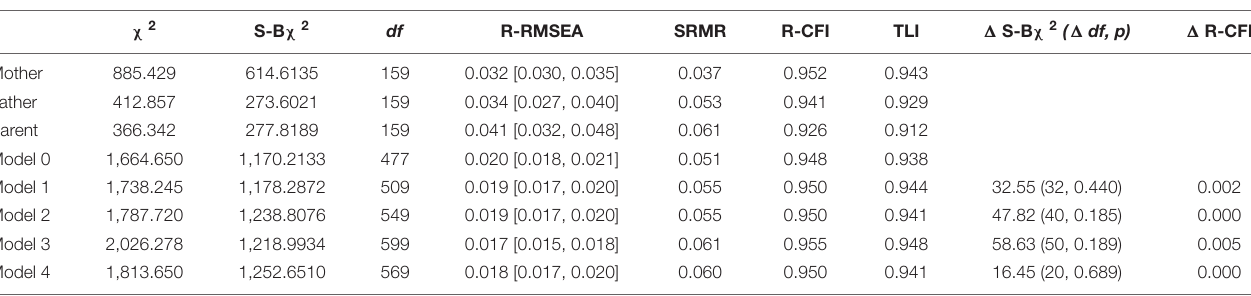
TABLE 6 | Goodness-of-fit indexes for CSAS-P depending on the parent who fulfilled the scale. χ